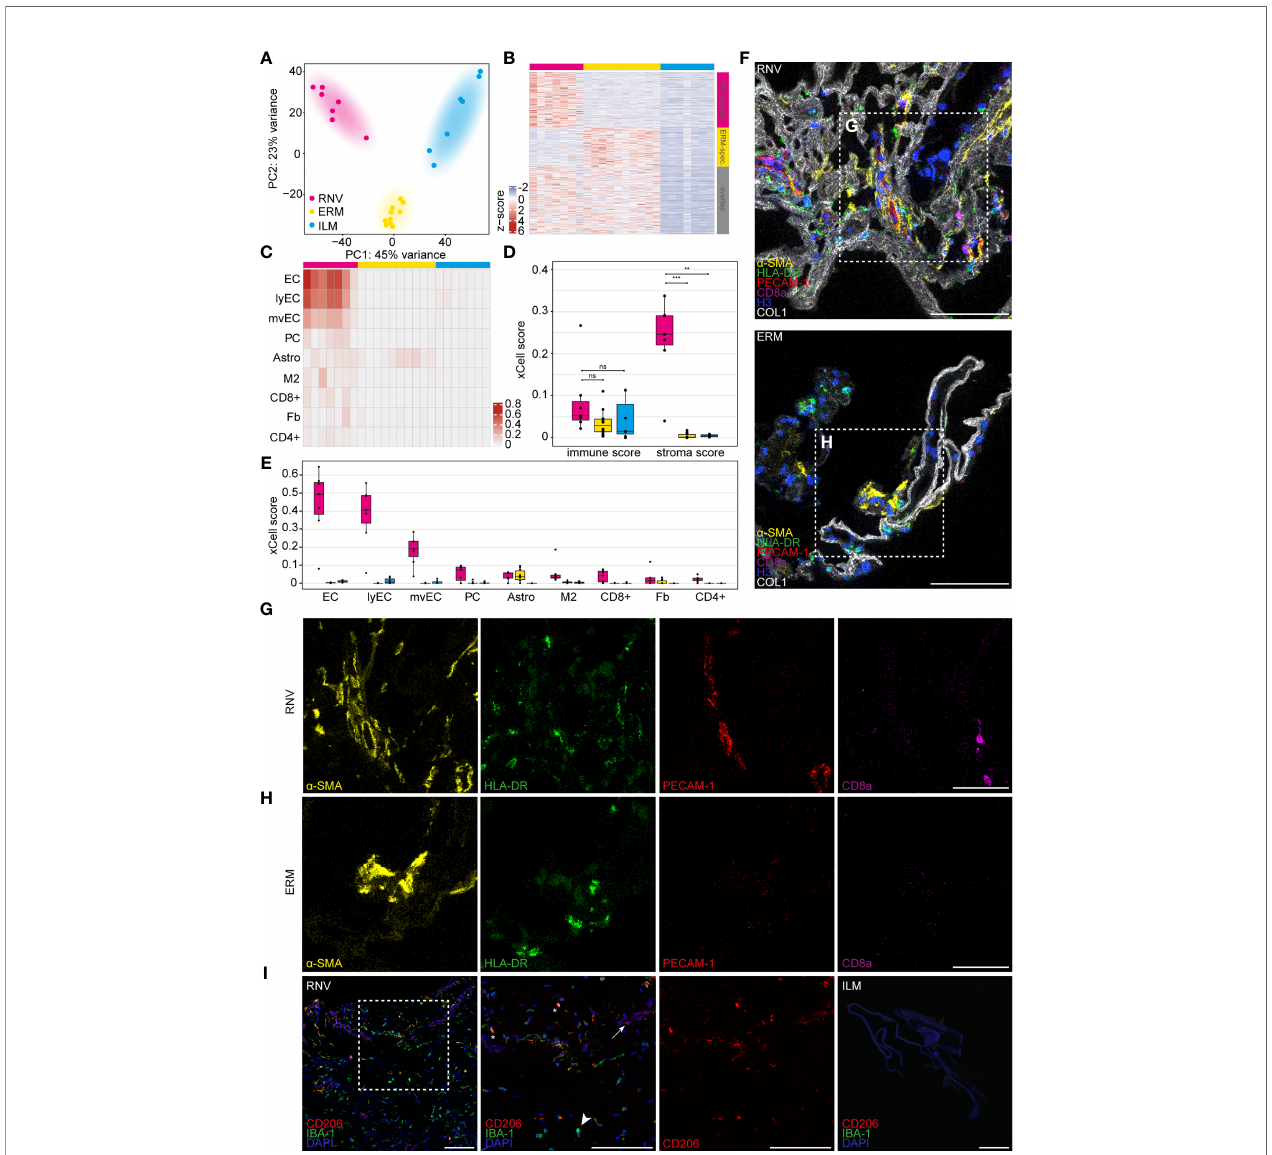
FIGURE 2 | Diabetic retinal neovascularization membranes (RNV) differ signi fi cantly in their cellular and molecular composition from epiretinal (ERM) and internal limiting membranes (ILM). (A) Principal component analysis (PCA) plot demonstrating the distribution of the three analyzed entities: RNV (magenta), ERM (yellow) and ILM (blue). (B) Heatmap of the genes upregulated in RNV (upper magenta bar) and ERM (upper yellow bar) when compared to ILM (upper blue bar). The side bars mark RNV-speci fi c (side magenta bar), ERM-speci fi c (side yellow bar) genes or the overlap between both (grey bar), each in comparison to ILM (log2 fold change >2, adjusted p value <0.05). Color coding of the transcripts according to the z-score (deviation from a gene ’ s mean expression in standard deviation units). (C) Heatmap of signi fi cantly enriched cell types in RNV (magenta) vs . ILM (blue) according to the xCell analysis. Each row represents one cell type, each column one sample. The rows are ordered according to the fold change of the mean enrichment scores between RNV and ILM. EC, endothelial cells. ly, lymphatic. mv, microvascular. PC, pericytes. Astro, astrocytes. M2, M2 macrophages. CD8+, CD8+ central memory T cell. Fb, fi broblasts. CD4+, CD4+ naive T cells. Color coding for cell types. (D) Boxplots of the xCell immune and stroma scores in RNV (magenta), ERM (yellow) and ILM (blue). Each dot represents one sample. * p < 0.05, ** p < 0.005, *** p < 0.0005. ns, not signi fi cant (Mann-Whitney U test). (E) Boxplots of signi fi cantly enriched cell types in RNV (magenta) vs . ILM (blue), ordered according to the log2 fold change between RNV and ILM. (F) Imaging Mass Cytometry on RNV and ERM tissue samples. Images are representative for all stained samples. Multiplexed staining for a -SMA ( a -smooth muscle actin, yellow), HLA-DR (human leukocyte antigen – DR isotype, green), PECAM-1 (platelet endothelial cell adhesion molecule, red), CD8a (magenta), Histone H3 (blue) and COL1 (collagen type I, white) is presented. Higher magni fi cation of the sections within the dashed white square is shown respectively in the panels in (G, H) Scale bars correspond to 100 m m (F) and 50 m m (G, H) . (I) Immunohistochemical staining for CD206 (Cluster of Differentiation 206) and IBA-1 (ionized calcium-binding adapter molecule 1) in RNV and ILM samples. Higher magni fi cation of the section within the dashed white square is shown to the right. Double-positive CD206 + IBA-1 + cells are tagged by an asterisk. Arrow points to a CD206 + IBA-1 - cell. Arrowhead points toward a CD206-IBA-1 + cell. Nuclei are counterstained with DAPI. Scale bars correspond to 100 m